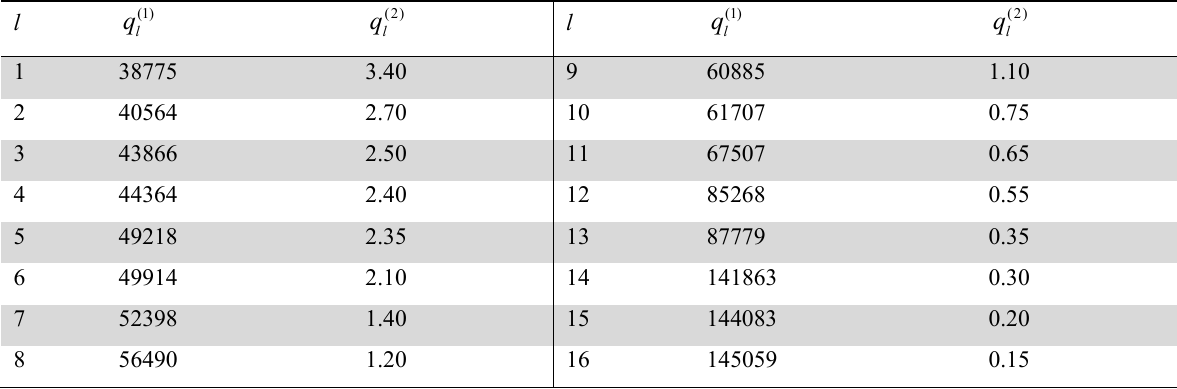
Elements of Pareto front PF